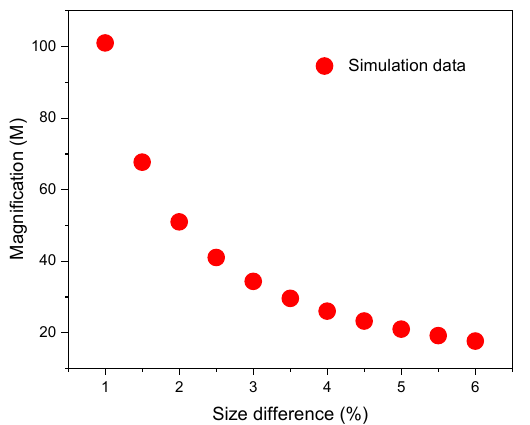
Figure 5. Variations of the magnification ( M ) as a function of the percentage of the size difference.